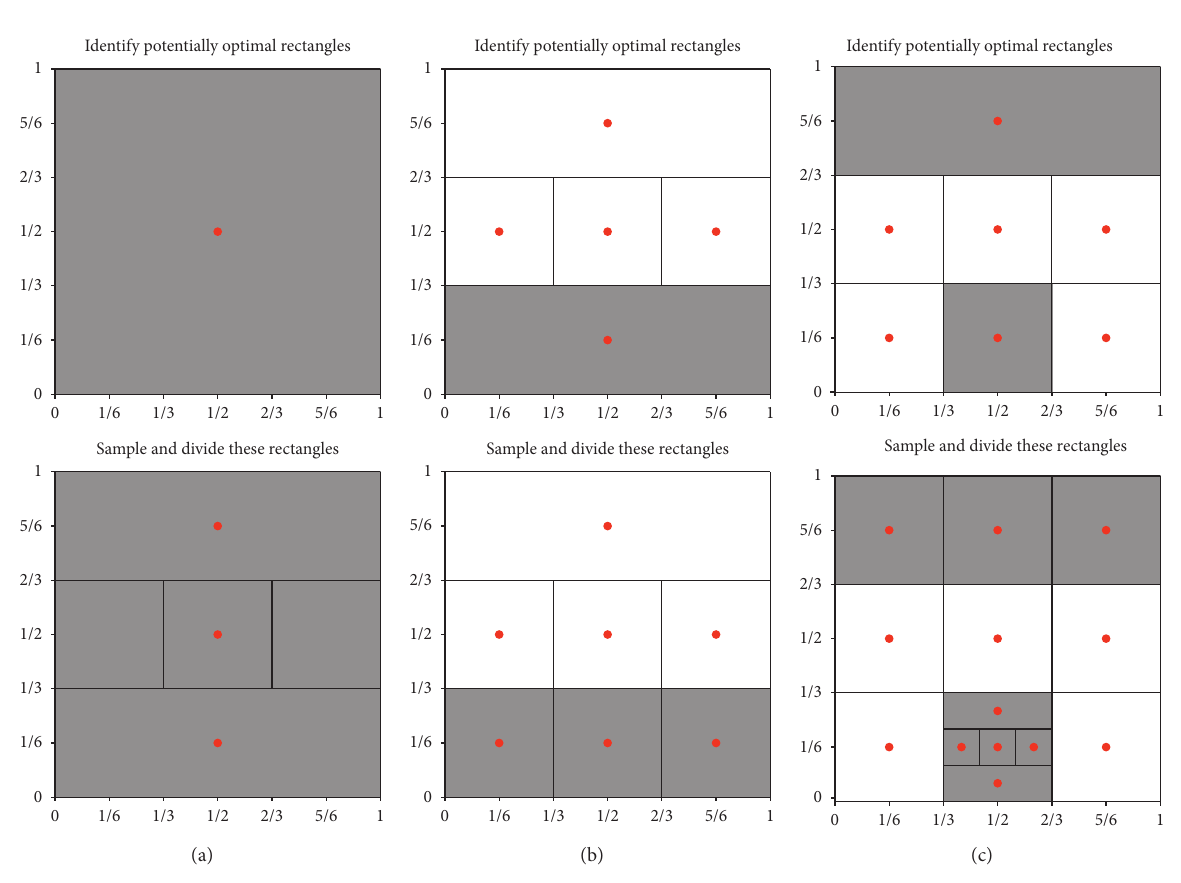
Figure 3: Three iterations of the DIRECT algorithm on Branin’s function: gray colored hyper-rectangles highlight potentially optimal ones. They are selected in the first phase of the current iteration and divided in the second phase of the current iteration. Red points are sample points where the performance function is evaluated. (a) Iteration 1, (b) Iteration 2, and (c) Iteration